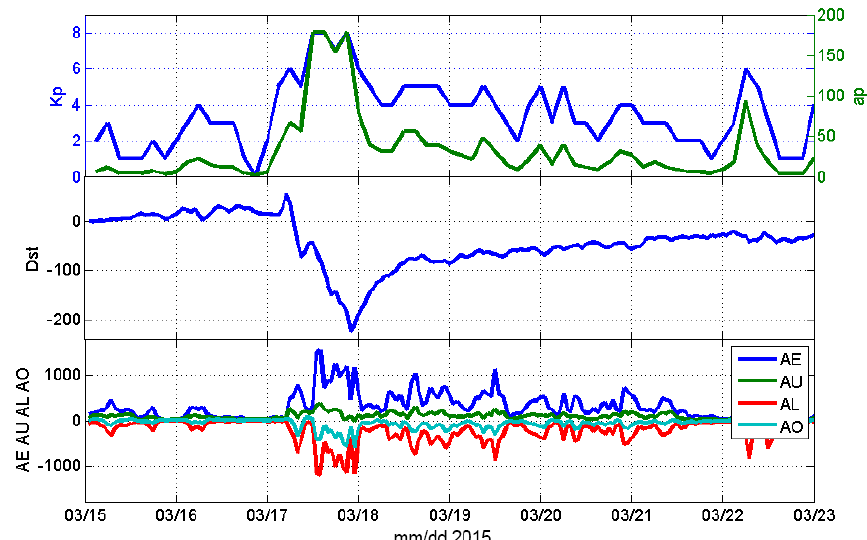
Figure 6. Variations of geomagnetic indices (Kp, ap, Dst, AE, AU, AL, and AO) during the magnetic storm of March 2015 (data from the International Service of Geomagnetic Indices (ISGI) website: http://isgi.latmos.ipsl.fr/ (last access: 10 September 2016)).